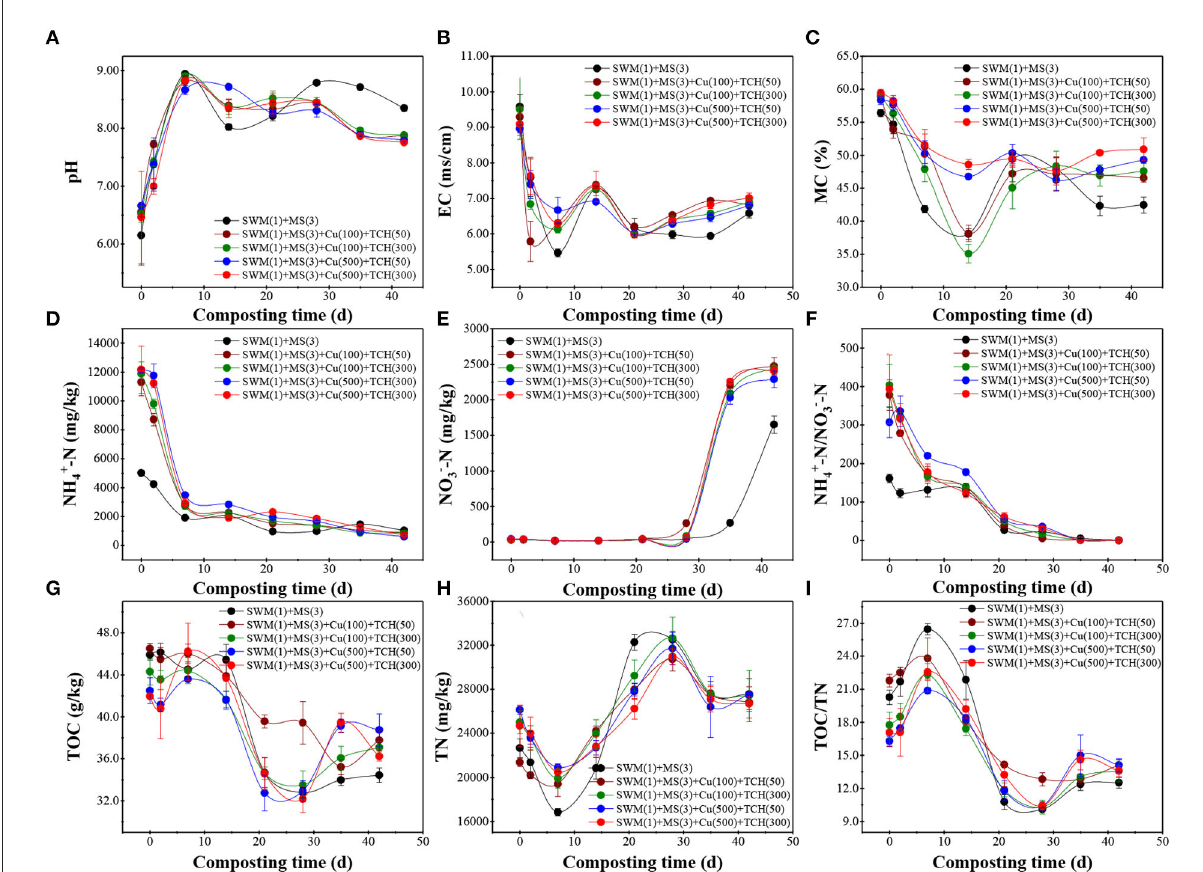
FIGURE2 (A–I) Dynamic changes in the physical and chemical parameters during the composting process.